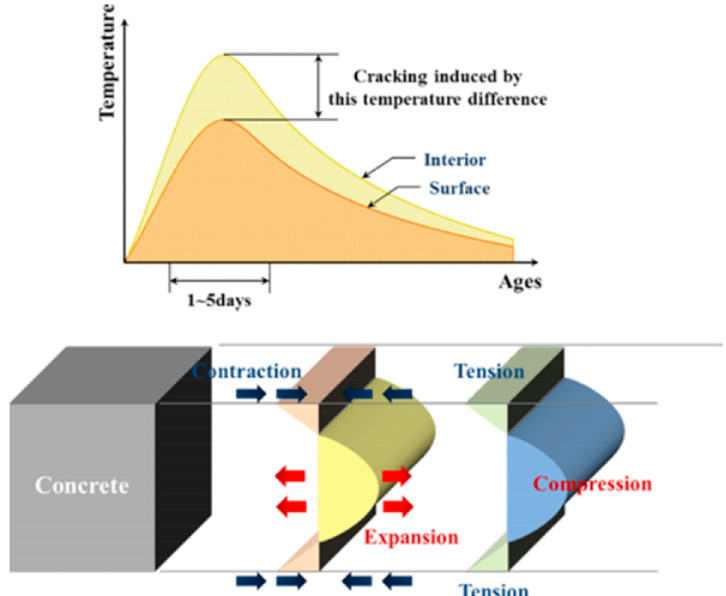
Figure 5. Internal stress induced by temperature gradients